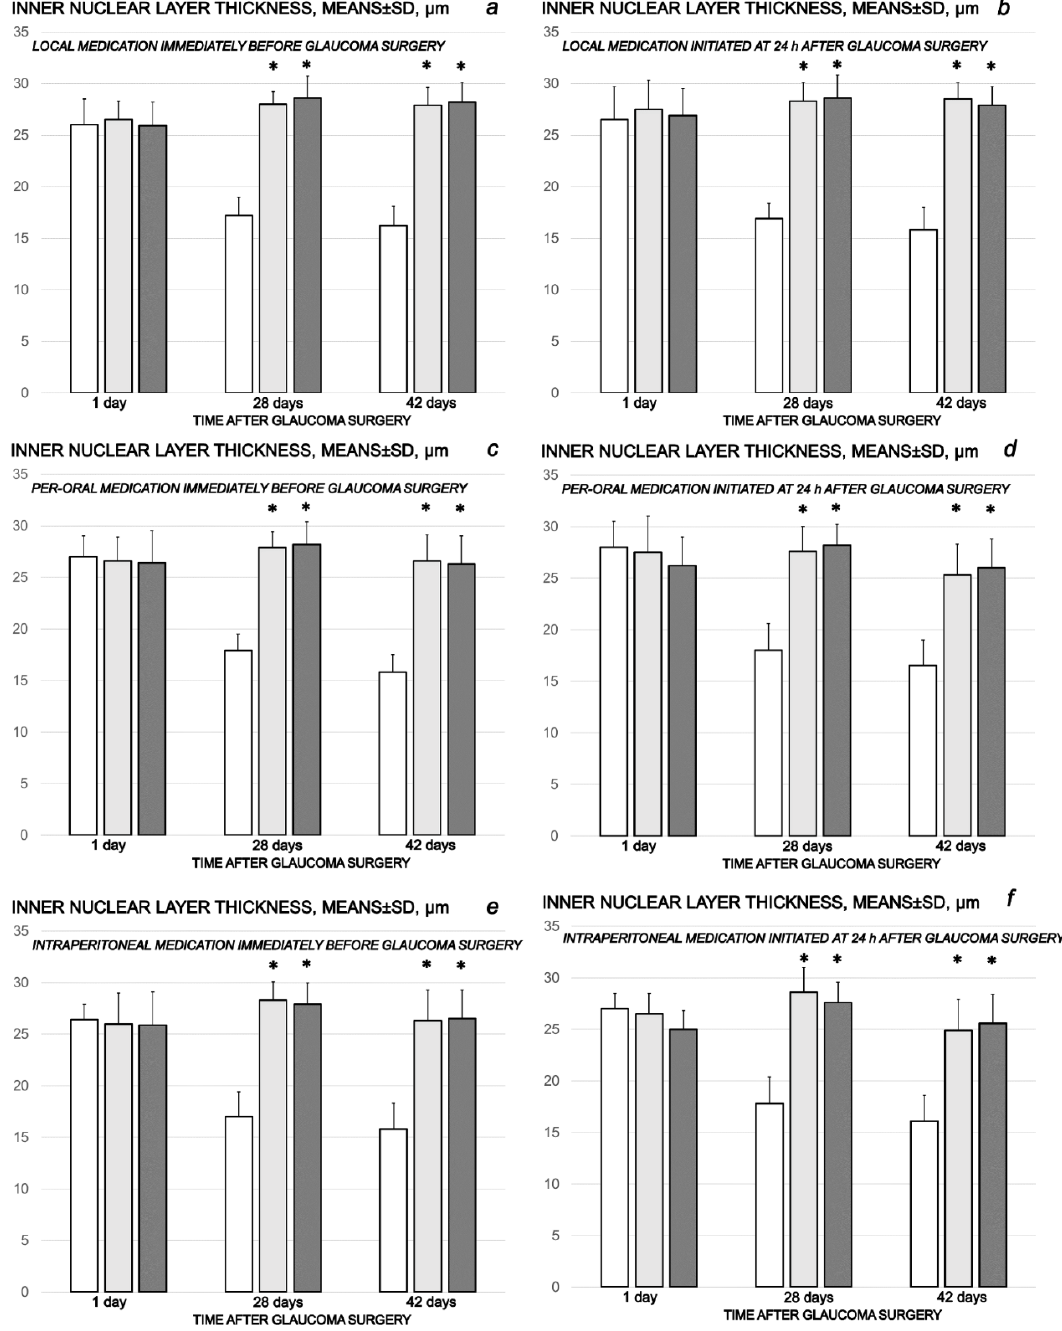
Figure 8. Cauterization of the three episcleral veins induced a decrease in retinal inner nuclear layer thickness, means ± SD, µ n, at the first post-operative day and at the end of the fourth and sixth post-injury week. Counteracting effect of BPC 157 medication daily regimen, prophylactic ( a – c ) or curative ( d – f ) (gray bars, light gray bars µ g-regimen, dark gray bars ng-regimen (0.4 µ g/eye, 0.4 ng/eye; 10 µ g/kg, 10 ng/kg) given locally as eye drops in each eye ( a , d ), intraperitoneally (last application at 24 h before sacrifice) ( b , e ) or per-orally in drinking water (0.16 µ g/mL, 0.16 ng/mL, 12 mL/rat until the sacrifice, first application given intragastrically) ( c , f )), started prophylactically (immediately before glaucoma surgery) or as curative treatment (at 24 h after glaucoma surgery). Controls (white bars) simultaneously received an equal volume of distilled water (two drops/eye), saline intraperitoneal application (5 mL/kg) or per-oral drinking water (12 mL/day/rat). A total of 6 rats/group/interval. * p < 0.05, at least, vs.